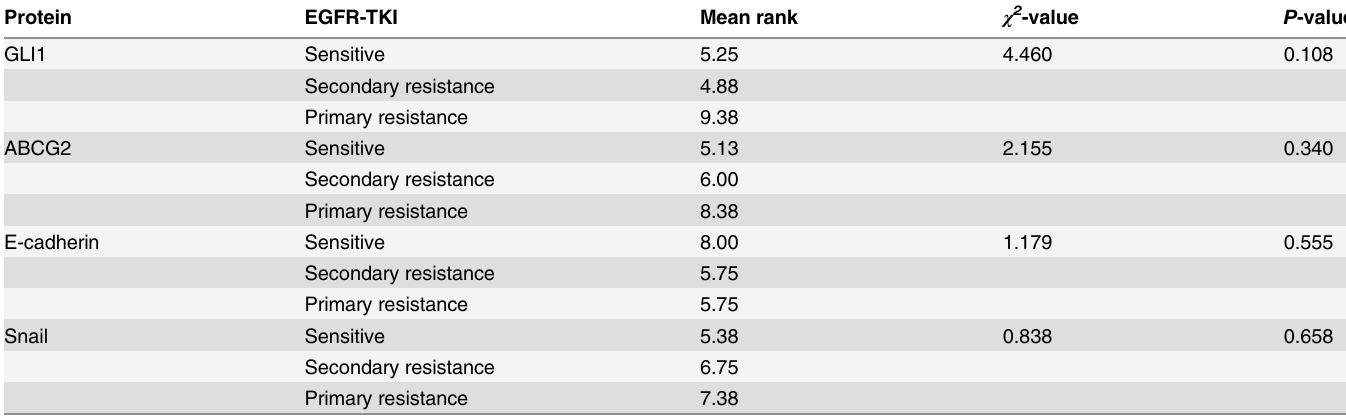
the Hh pathway was silenced in EGFR-TKI-sensitive cells. The difference in Hh signaling activ- ity between EGFR-TKI-sensitive and -resistant cells suggested that aberrant activation of the Hh signaling pathway may contributes to EGFR-TKI resistance by inducing an EMT pheno- type and ABCG2 upregulation. To confirm these findings, Hh signaling was upregulated using extrinsic SHH in the EGFR-TKI-sensitive PC9 cell line. Upregulation of Hh activity resulted in induction of EMT and elevation of ABCG2 expression. Hh signaling hyperactivity also resulted in EGFR-TKI tolerance in otherwise EGFR-TKI-sensitive cells. These results confirmed that aberrant activation of Hh signaling resulted in the development of EGFR-TKI resistance in NSCLC cells through induction of EMT and ABCG2 overexpression. Inhibition of Hh signal- ing by the Hh inhibitor SANT-1 enhanced E-cadherin expression and downregulated Snail and ABCG2 expression. This result demonstrated that blockade of Hh signaling can reverse the EMT phenotype and maybe reduce CSC abundance. A previous study indicated that restor- ing E-cadherin expression increased sensitivity to EGFR-TKIs in vitro and in vivo [38]. Based on these results, we had reason to believe that targeting the Hh signaling pathway could affect EGFR-TKI resistance in NSCLC cells. Thus, we next treated EGFR-TKI-resistant cells with gefitinib or SANT-1 alone or gefitinib plus SANT-1. The results indicated that compared with either gefitinib or SANT-1 alone, the combination of gefitinib plus SANT-1 significantly Table 2. Expression differences of GLI1, ABCG2, E-cadherin and Snail in EGFR-TKIs sensitive and resistant tissues. Protein EGFR-TKI